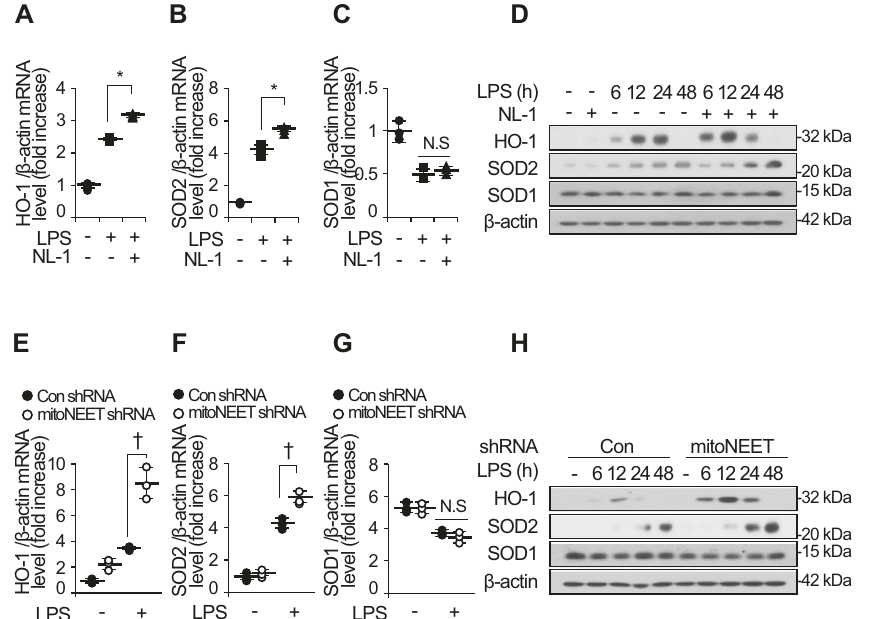
Fig. 7 Inhibition of mitoNEET increases expression of antioxidant defense genes. Control shRNA-expressing or mitoNEET-expressing RAW264.7 cells were treated with vehicle, LPS (1µg/mL), or LPS plus NL-1 (20µM). Total RNA and protein were harvested 12h later, followed by measurement of mRNA encoding HO-1, SOD2, or SOD1 by quantitative real-time RT-PCR ( A – C and E – G ). Expression of HO-1, SOD2, and SOD1 protein was detected by western blotting ( D and H ). All data are expressed as the mean±SD from three independent experiments. *P <0.05 for LPS vs. LPS plus NL-1 treatment. † P <0.05 for control shRNA-expressing cells vs. mitoNEET shRNA-expressing cells in the presence of LPS. NS, not signi fi